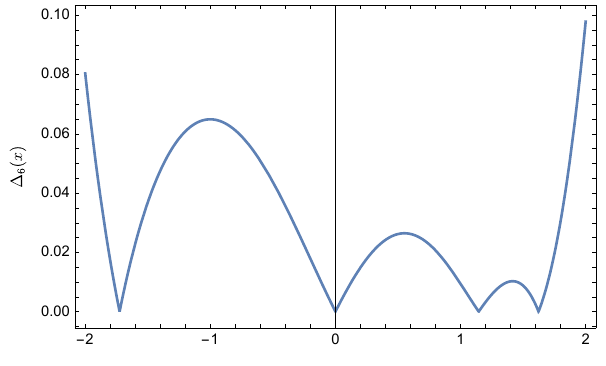
Figure 6. Error ∆ 6 of approximation y 6 ( x ) .